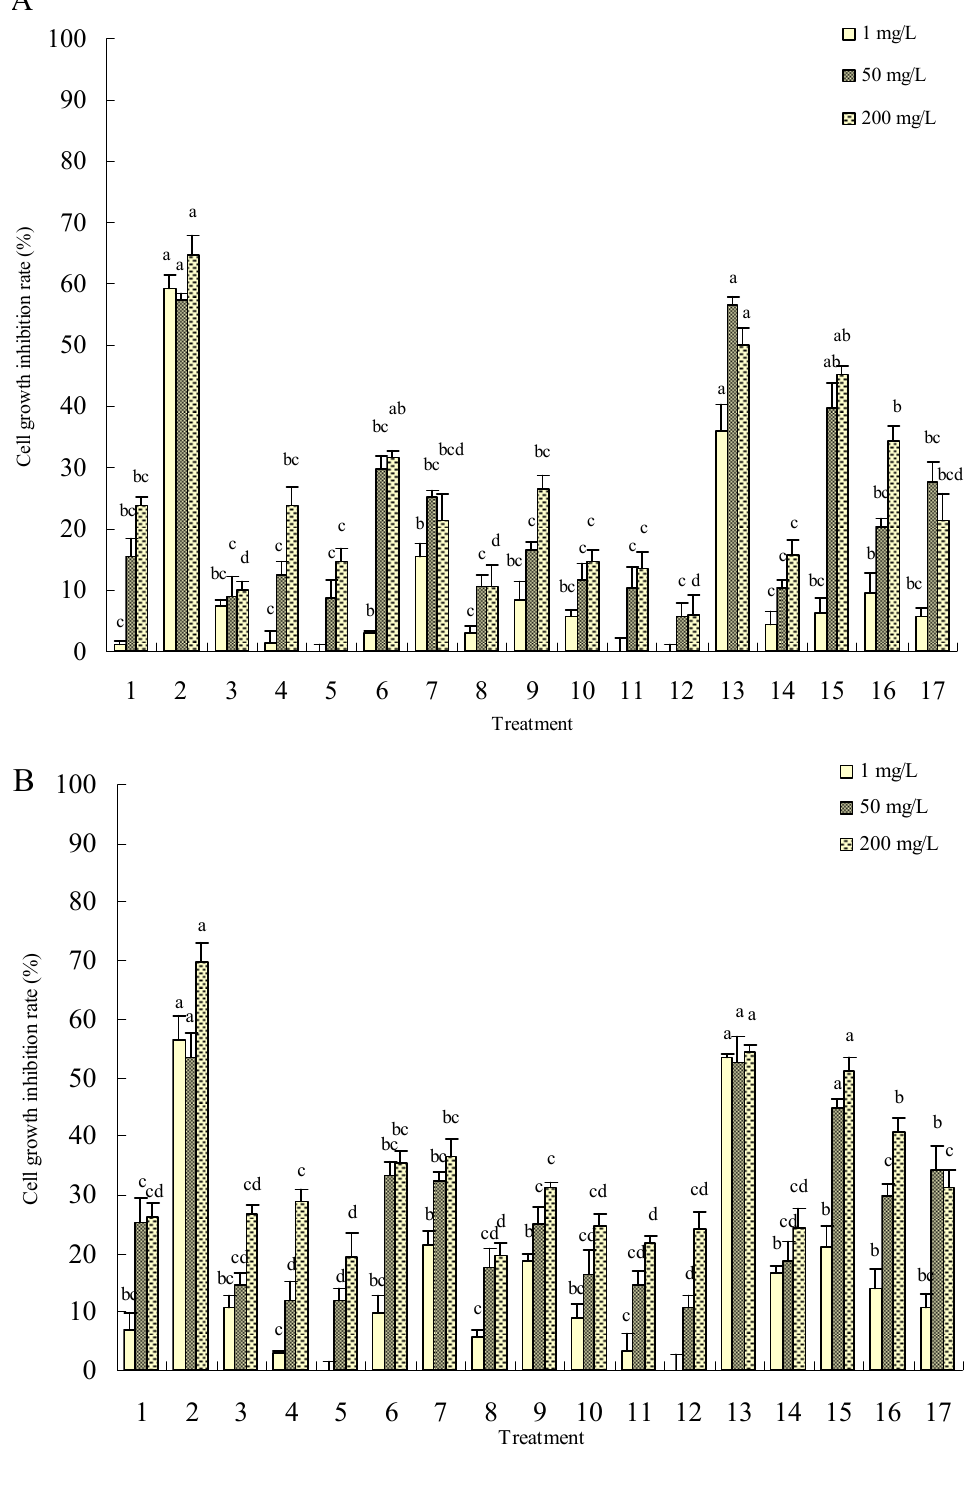
Figure 1. Cytotoxic effect of compounds 1-16 in insect cell line Sf9 determined by the MTT method. A is the effect of 6 h treatment; B is the effect of 12 h treatment; C is the effect of 24 h treatment. Treatments 1-16 are the synthesized compounds and treatment 17 is harmine, a positive control. The error bars represent mean±SEM for data derived from three independent experiments. Mean values followed by the same letter above bars have no significant difference (P ≤ 0.05) according to Duncan’s multiple-range